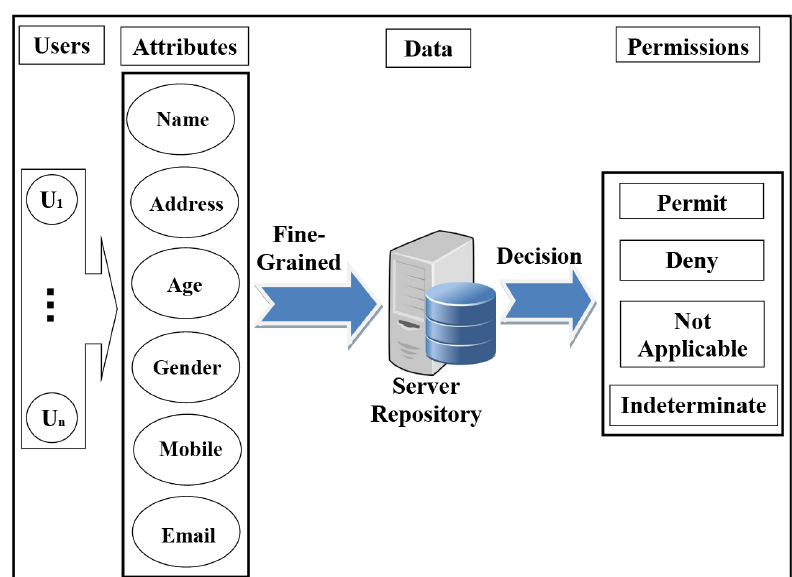
Figure 2. Scheme of attribute-based access control (ABAC)